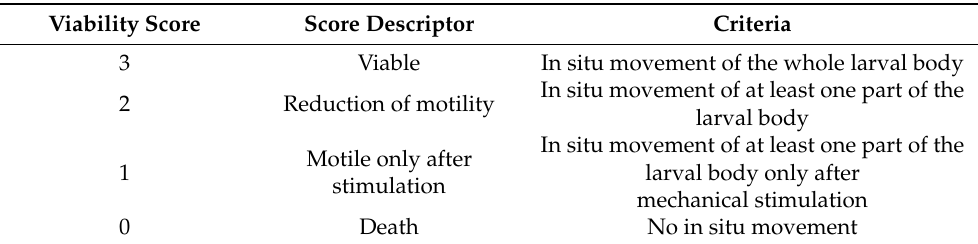
Table 1. Evaluation of the Anisakis “viability score” inspired by the classification of Hirasa and Takemasa [51] implemented according to Guan et al.